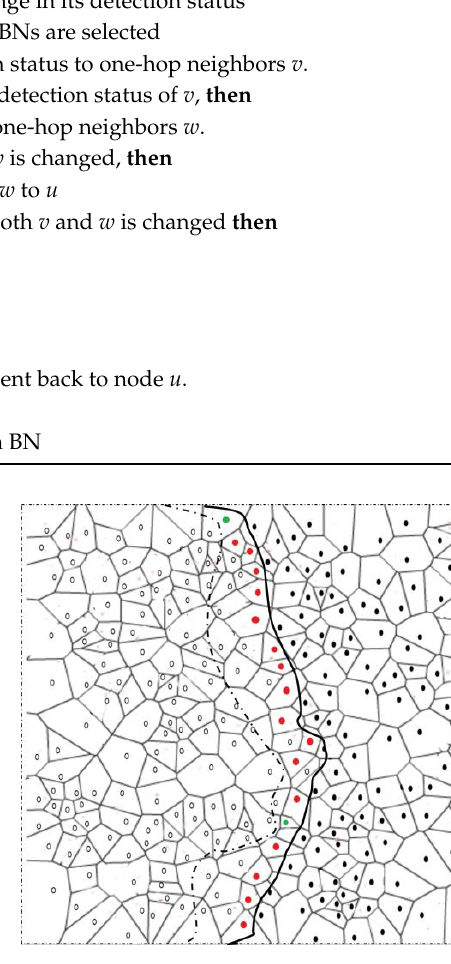
Figure 3. Boundary node selection. Nodes having a two-hop changed detection status become strong boundary nodes (BNs) (red dots), whereas nodes with a one-hop changed detection status become normal BNs (green dots). Nodes represented with hallow circles describe the detecting nodes, while nodes represented with solid black circles describe the non-detecting nodes at any given time.